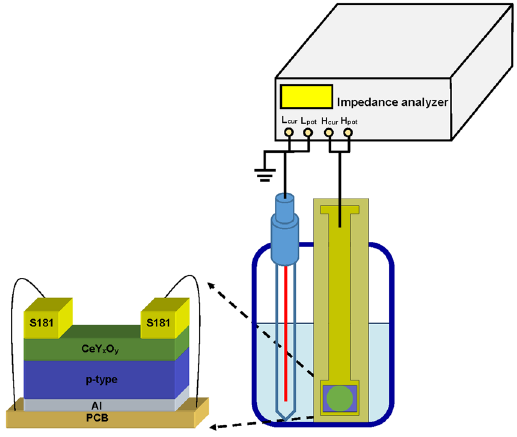
Figure 1. Schematic representation of the structure of a CeY x O y EIS